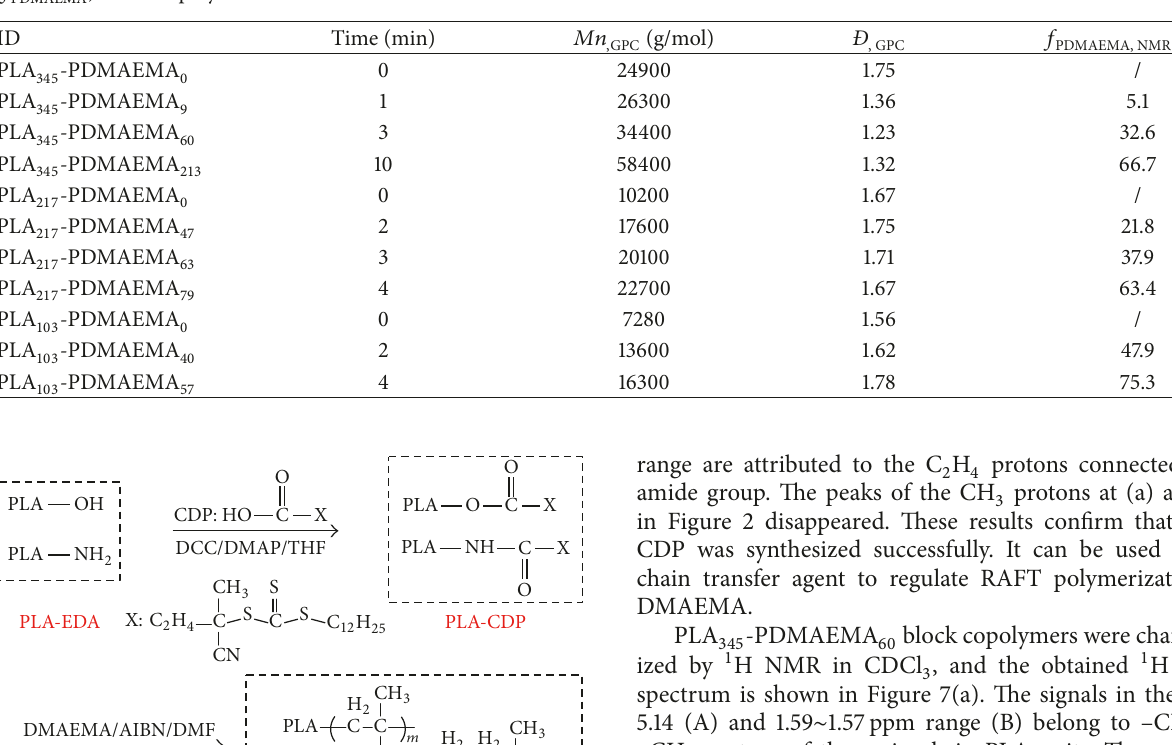
Table 1: Molar weight ( Mn ), polydispersity ( K ) of the synthesized PLA-PDMAEMA block copolymers, and mass ratio of PDMAEMA blocks (𝑓 ) in the copolymers. PDMAEMA